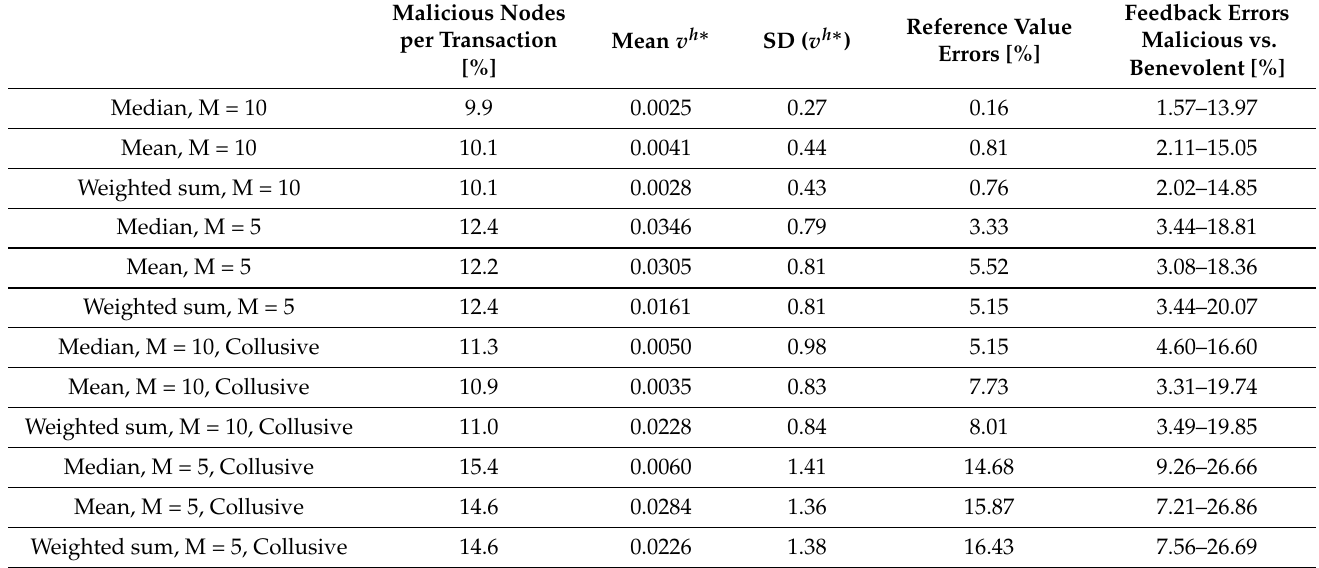
Table 3. Comparison between simple and collusive